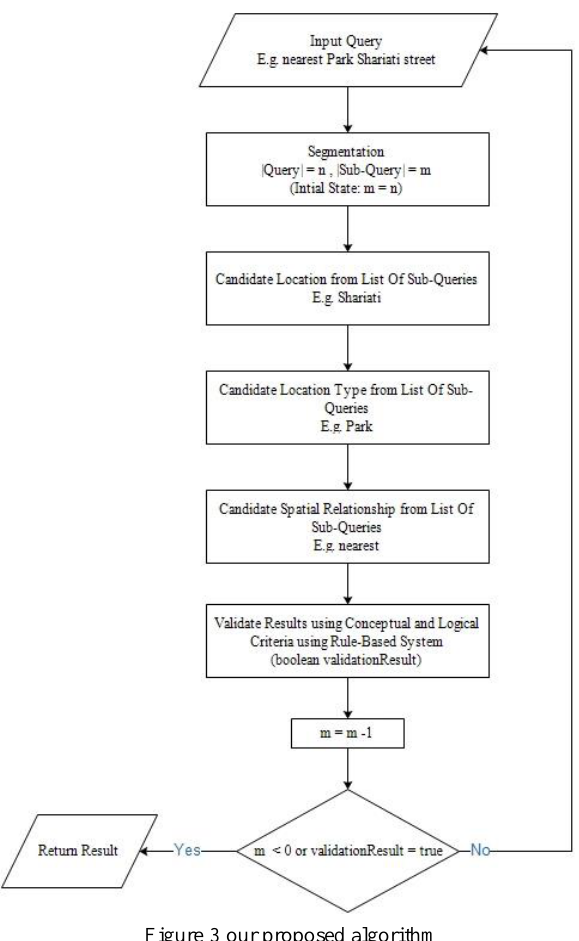
Figure 3 our proposed algorithm